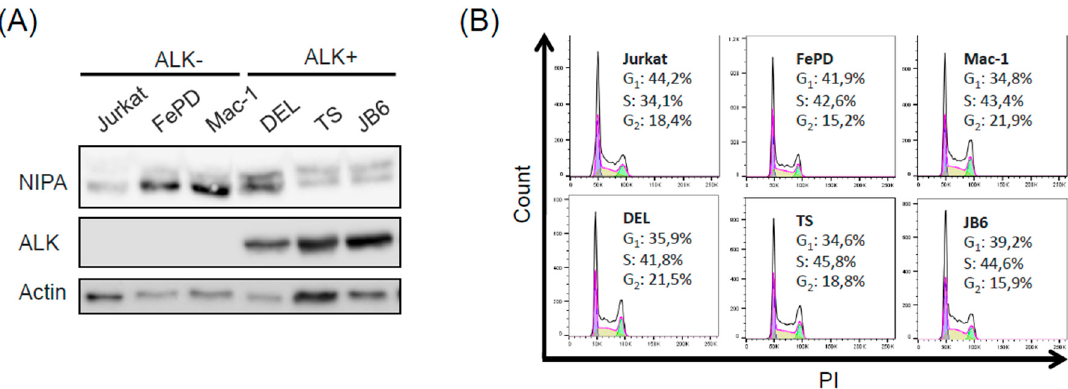
Figure 1. Phosphorylation of NIPA in anaplastic large-cell lymphoma (ALCL) cells is induced in an NPM-ALK-dependent manner ( A ) ALK - and ALK + cells were used to examine the phosphorylation status of NIPA with immunoblot analysis. ( B ) Cell staining with propidium iodide revealed equal amount of cells in G 2 / M to exclude cell-cycle-dependent phosphorylation di ff